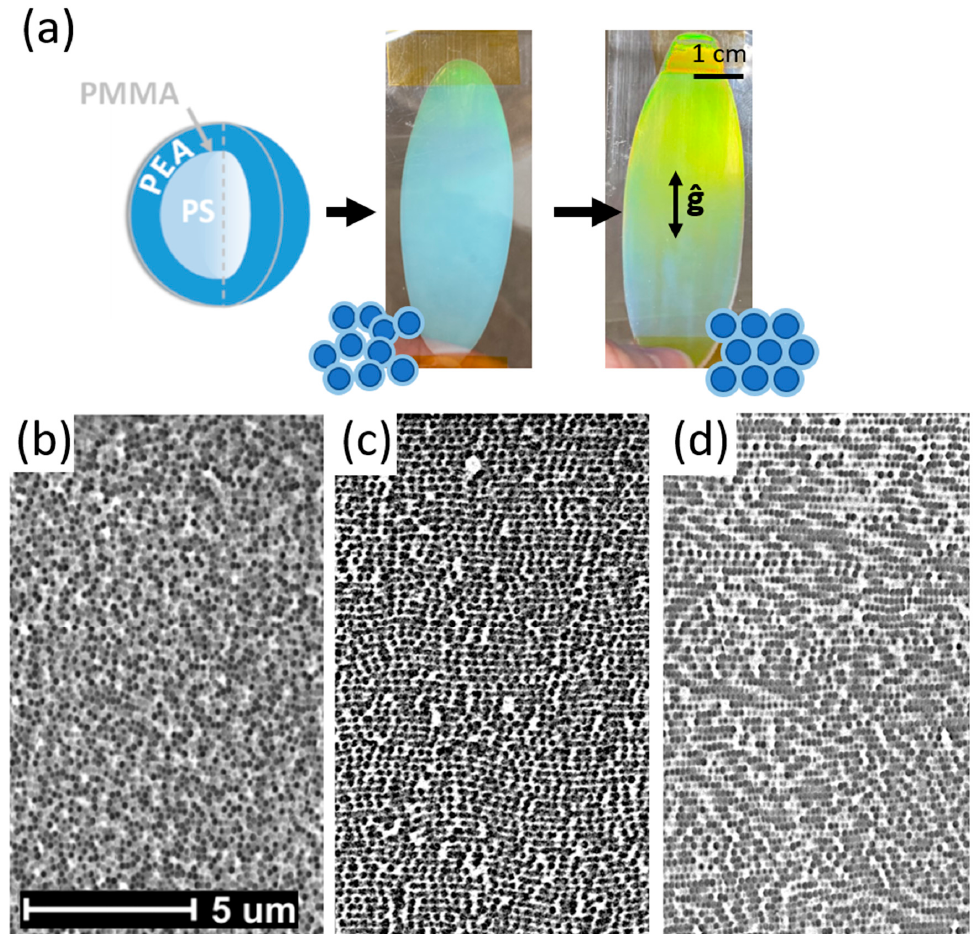
Figure 1. ( a ) Polymer opals are fabricated from composite nanoparticles of polystyrene (PS) cores coated in a poly(ethyl acrylate) (PEA) shell, grafted to the core by a poly(methyl methacrylate) (PMMA) interlayer. These begin as amorphous films characterized by a milky appearance, before being sheared into arrays giving saturated structural color of wavelength corresponding to core diameter. Transmission electron microscopy (TEM) of film slices of ( b ) 0 BIOS, ( c ) 20 BIOS, and ( d ) 40 BIOS are shown on a common scale, with the film edges shown at the top of the figures. Structural order is seen to iteratively improve and permeate into the films with further shear as the PS cores self-assemble within the PEA matrix. A value of 40 BIOS POs are shown to demonstrate excellent order across areas of 10s of particles, with the PS cores arranged neatly over many layers. Some figure elements have previously appeared in [20] and have been digitally enhanced.